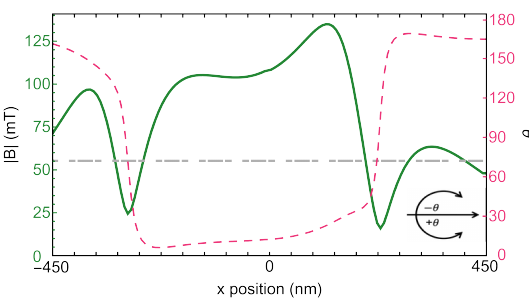
Figure 2: Magnetic field profile, as a function of position, of the four magnet Drag- onfly setup. Solid line is field amplitude and dashed line is field angle θ relative to negative x-axis (inset). The field is averaged over a hexagonal cross-section of the nanowire with a characteristic dimension of 100 nm. In this Figure only, the reader is invited to imagine an infinitely long nanowire without ends and consider what field profile would be created along such a nanowire. The horizontal dashed gray line indicates a uniform field for entering the topological regime in an infinite